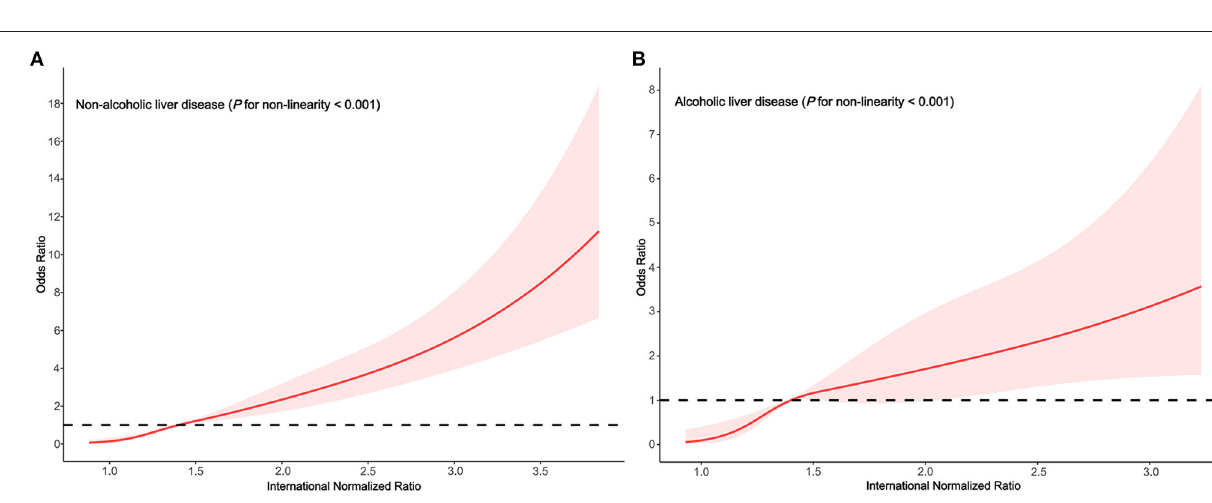
FIGURE 3 | Association between the INR and HE risk based on restricted cubic spline model stratified by alcoholic liver disease (A) no; (B)